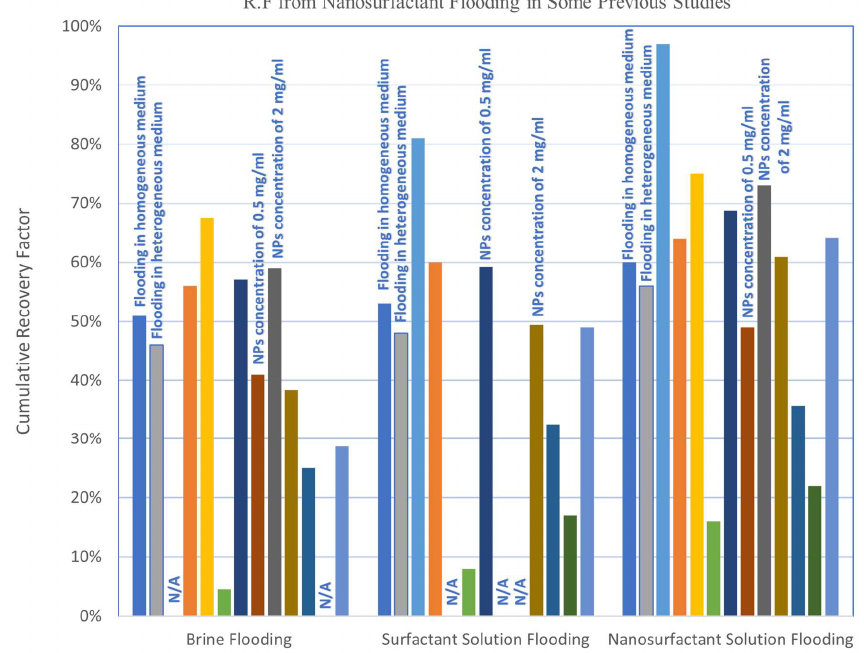
Figure 9. A summary of the recovery factor results for some studies that integrate NPs in surfactant EOR. (Gaps shown as N/A mean that the subsequent study/reference did not conduct an